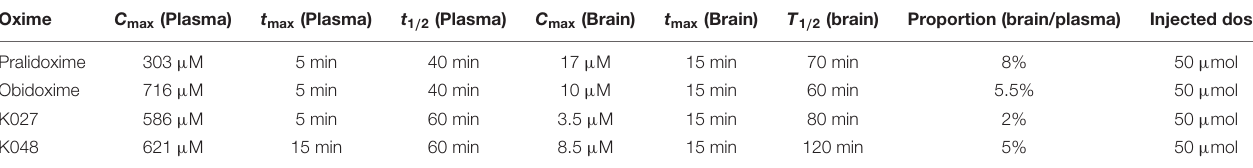
TABLE 1 | Pharmacokinetic parameters of the experimental K-oximes K024 and K048 and of the established oximes pralidoxime and obidoxime. Oxime C max (Plasma) t max (Plasma) t 1 / 2 (Plasma) C max (Brain) t max (Brain) T 1 / 2 (brain) Proportion (brain/plasma) Injected dose Pralidoxime 303 µ M 5 min 40 min 17 µ M 15 min 70 min 8% 50 µ mol Obidoxime 716 µ M 5 min 40 min K027 586 µ M K048 621 µ M 15 min 60 min 120 min 5% 50 µ mol Column 2 lists the maximum concentration (C max ) measured in plasma and column 3 the time after which it is reached (t max ). Column 4 lists the half-life (t 1/2 ) in plasma of the respective oxime. Columns 5–7 list the same parameters for the brain and column 8 the proportion of oxime reaching the brain, determined as the area under the concentration curve (AUC) for brain as a fraction of the AUC for plasma. Column 9 lists the dose injected intramuscularly into rats to determine pharmacokinetics. Data from Lorke et al. (2007) and Petroianu et al.